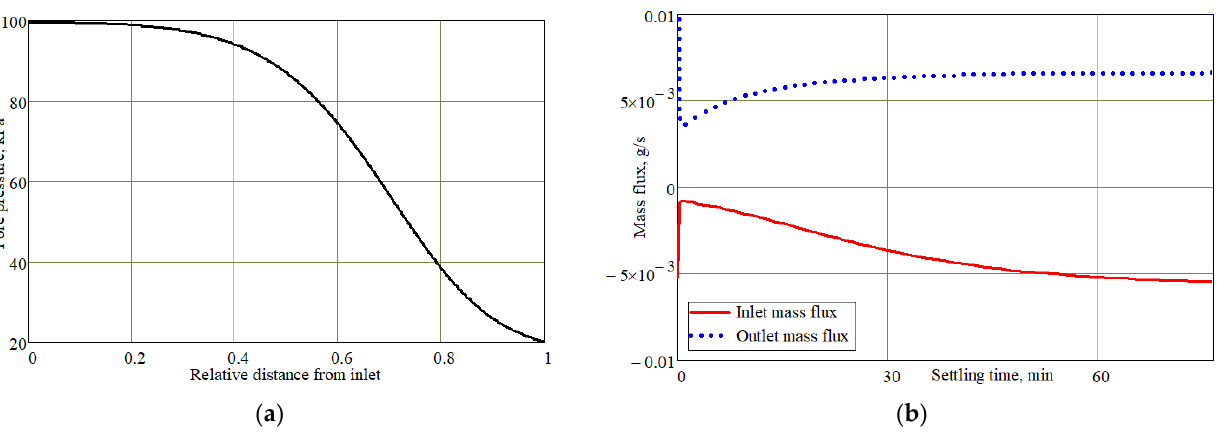
Figure 4. To the definition of the initial condition for pore pressure in the preform (explanation in text): ( a ) The plot of the auxiliary function p 0 m ; ( b ) Determination of the end point of resin flow stabilization (Mass flows have different signs because they are differently oriented with respect to the normal vectors of inlet and outlet).